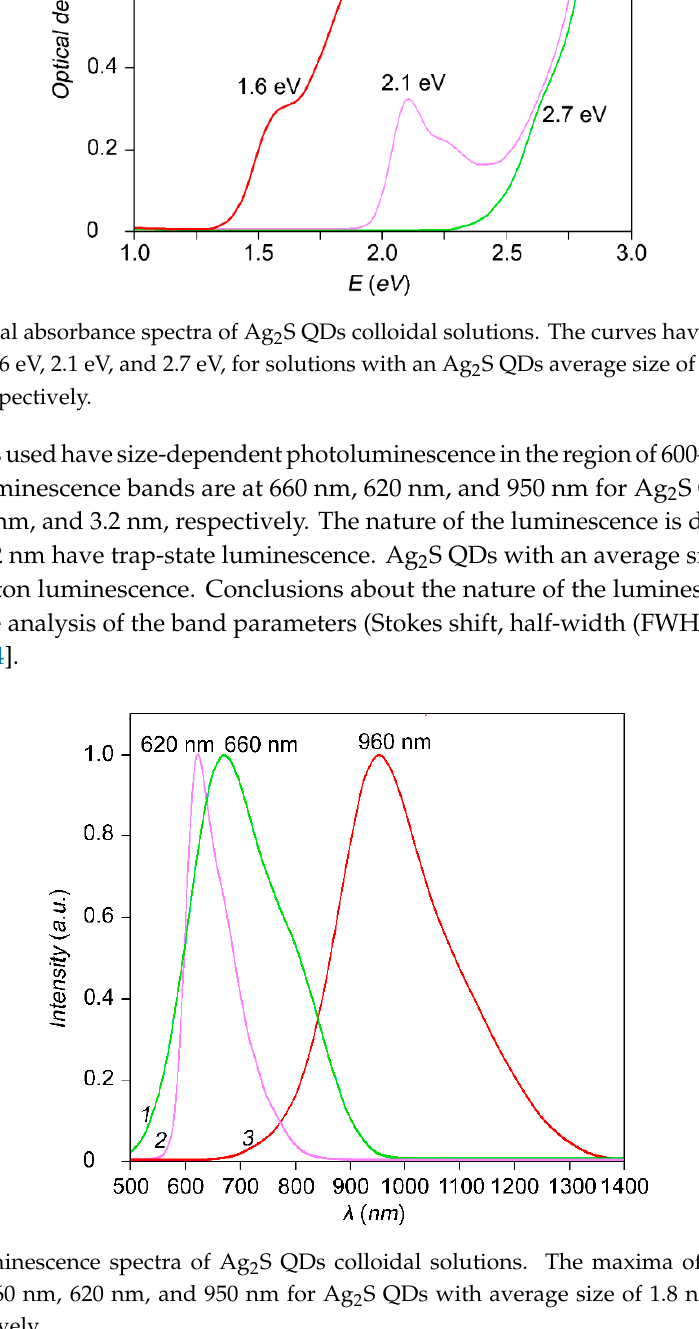
Figure 2. Optical absorbance spectra of Ag 2 S QDs colloidal solutions. The curves have characteristic features at of 1.6 eV, 2.1 eV, and 2.7 eV, for solutions with an Ag 2 S QDs average size of 3.2 nm, 2.0 nm, and 1.8 nm, respectively.